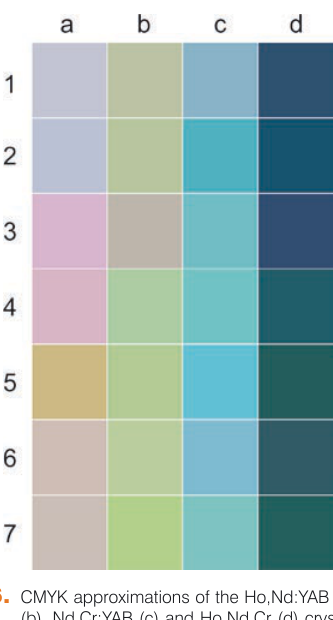
Figure 6. CMYK approximations of the Ho,Nd:YAB (a); Ho,Cr:YAB (b), Nd,Cr:YAB (c) and Ho,Nd,Cr (d) crystal colours un- der illumination with seven white light sources. 1: fl. lamp type 32, 2: fl. lamp type 33, 3: fl. lamp type 840, 4: fl. lamp type 960, 5: white LED, 6: tungsten lamp, 7: daylight CIE